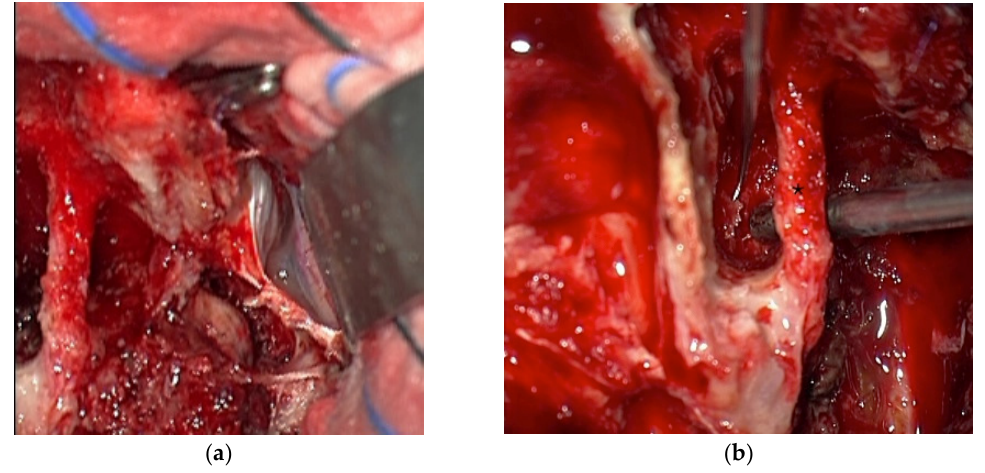
Figure 3. ( a ) Intraoperative image of the tumor invading the intra ‐ and extradural jugular foramen. The sigmoid sinus is ligated; ( b ) Image of the facial nerve * within the fallopian bridge.